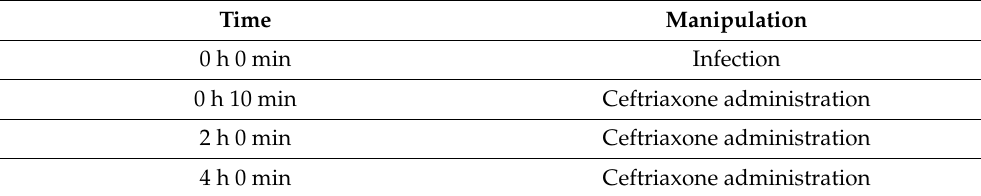
Table 4. Infection–treatment manipulations with the mice of IV and IP groups.